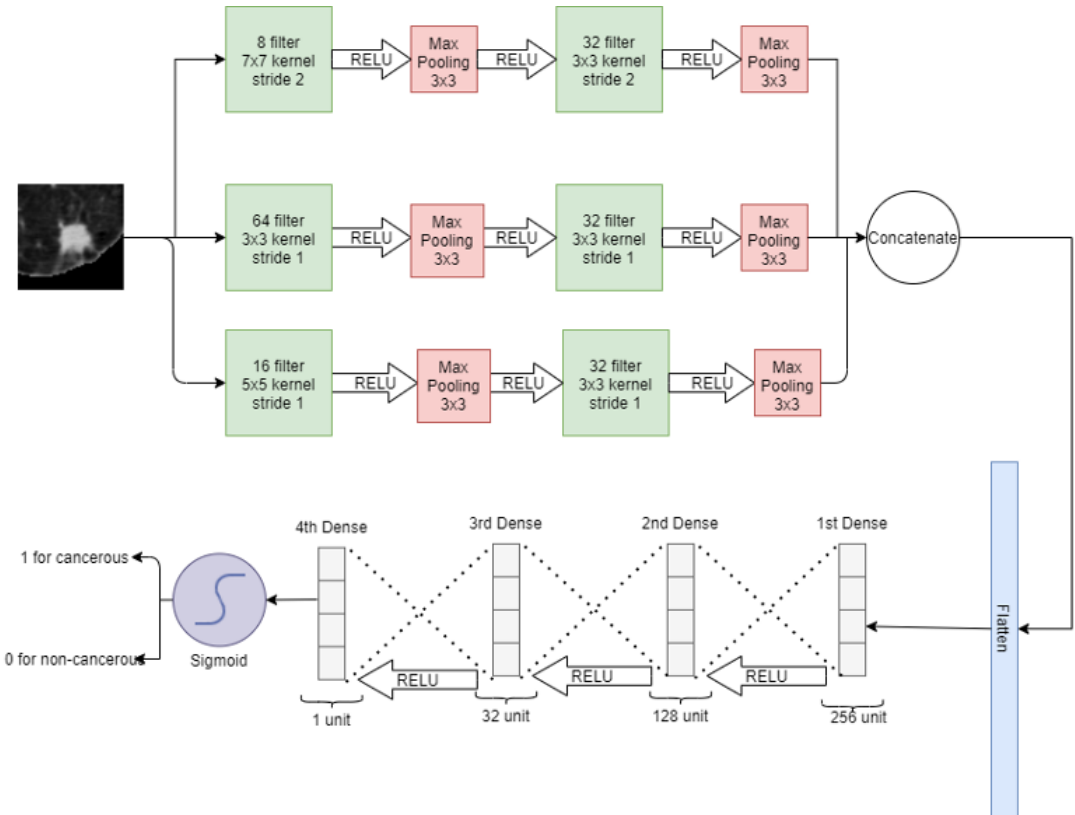
Figure 6. Wide neural net for classification of lung